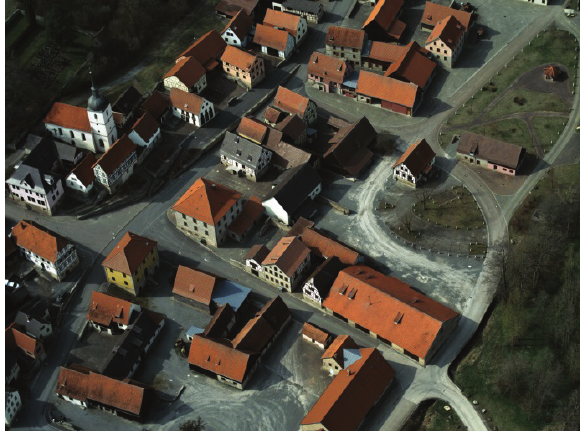
Figure 14. Single oblique image